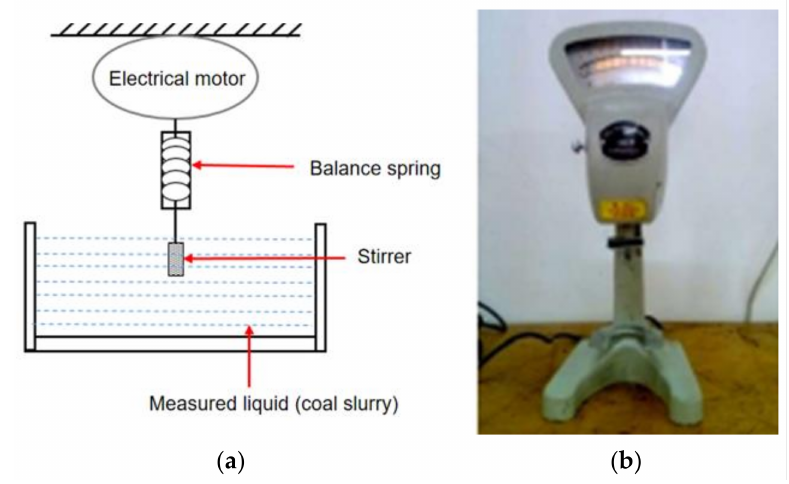
Figure 4. ( a ) Schematic diagram of the viscosity test; ( b ) the photo of the testing rig. The quality of the coal mine water was also tested in the laboratory, as shown in Figure 5. Ten samples (500 mL for each sample) were collected from the longwall face and the details were carefully recorded (including time, location).